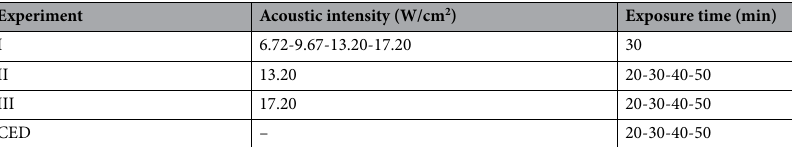
Table 1. Details of the experiments. Experiment I was conducted at a constant exposure time with four different acoustic intensities. On the contrary, in Experiments II and III, the exposure time was changed from 20 to 50 min, and acoustic intensities were adjusted at 13.20 and 17.20, respectively.